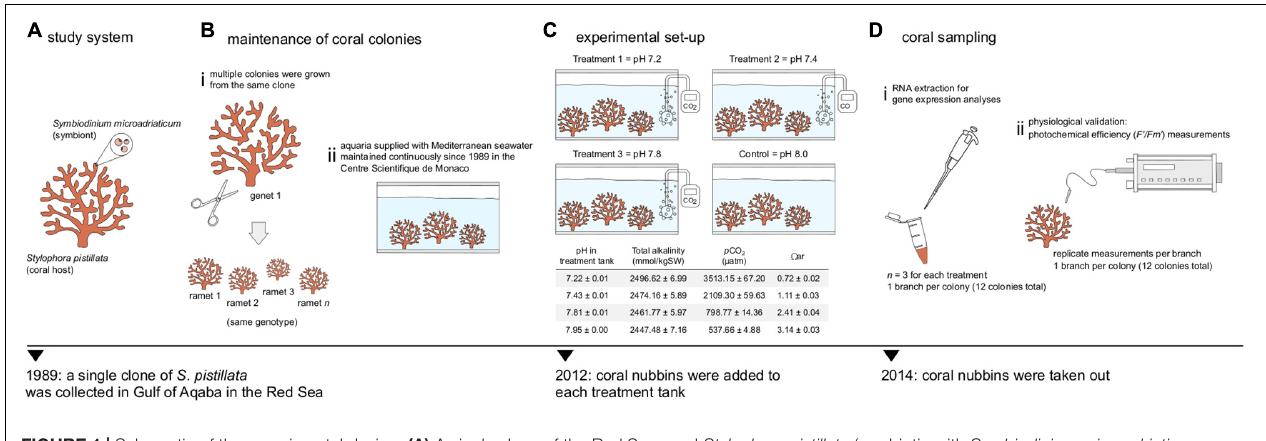
FIGURE 1 | Schematic of the experimental design. (A) A single clone of the Red Sea coral Stylophora pistillata (symbiotic with Symbiodinium microadriaticum CCMP2467) was collected in 1989. (B) The same coral colony was (i) fragmented into multiple nubbins and (ii) maintained in the aquaria system of the Centre Scientifique de Monaco. (C) At least 3 nubbins were added to different pH treatments in 2012: pHs 7.2, 7.4, 7.8 and a control pH 8.0. Details on carbonate chemistry are shown as means ± SD; (cid:127) ar, saturation state of aragonite [taken from Liew et al. (2018)]. (D) Coral nubbins were retrieved in 2014 after being subjected to their respective treatments for 2 years. (i) RNA extractions were performed and (ii) photochemical efficiency ( F’/Fm’ ) were measured to analyze changes in gene expression and assess the photo-physiological status, respectively.